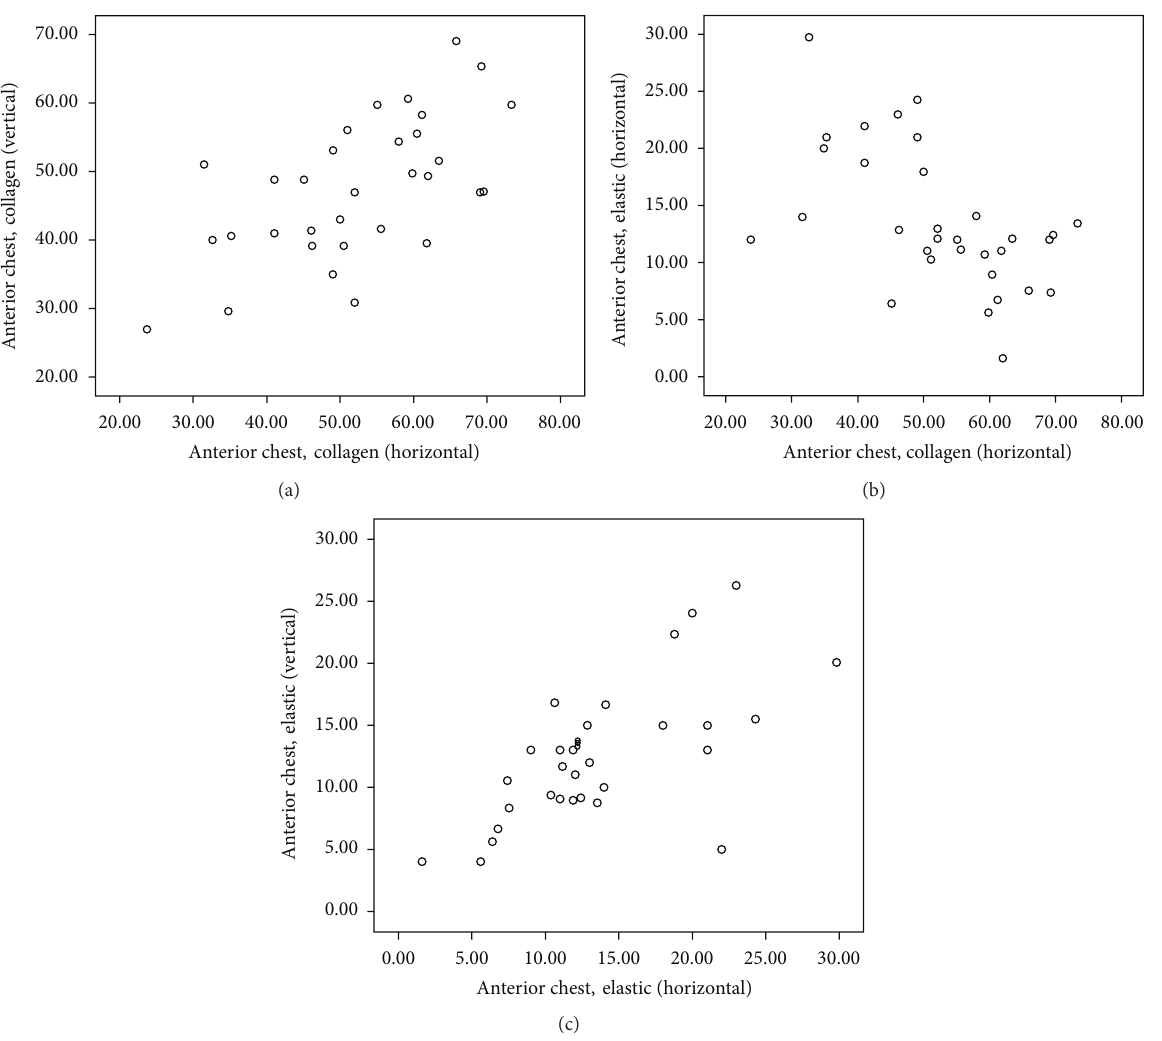
Figure 2: Scatter plot of significant Spearman correlation pattern at anterior chest area. (a) Moderate positive correlation between C H and C V . (b) Moderate negative correlation between C H and E H . (c) Moderate positive correlation between E H and E V (C H : collagen in horizontal, C V : collagen in vertical, E H : elastic in horizontal, and E V : elastic in vertical direction).